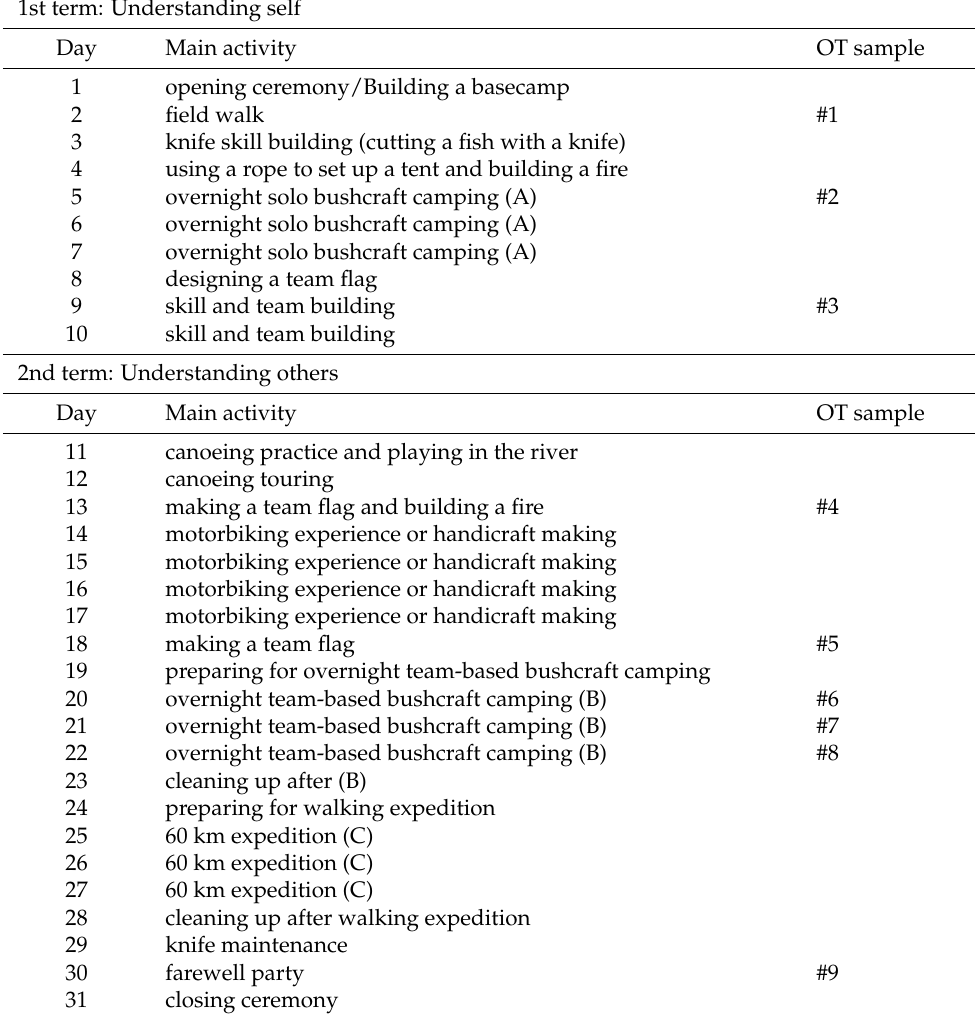
Table 1. Schedule of the 31-day wilderness